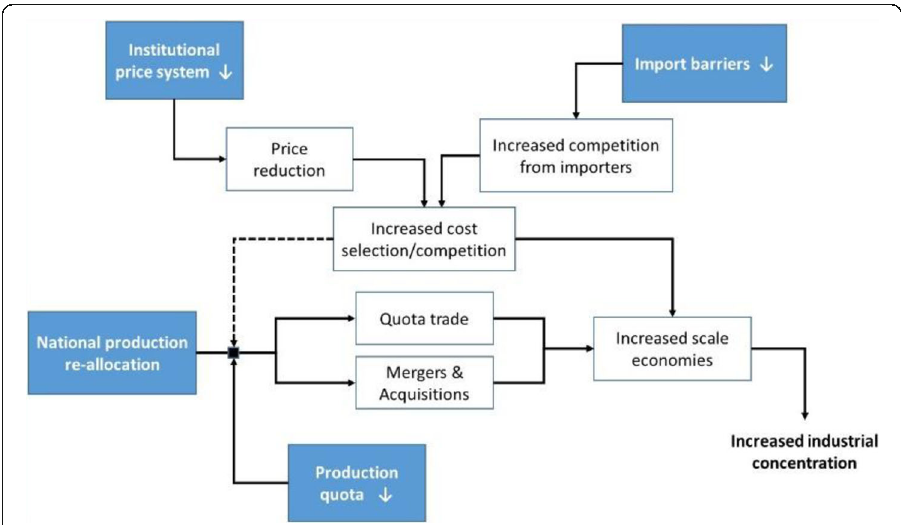
Fig. 1 Potential effect of sugar CMO Reform on concentration. Adapted from Areté srl Research and Consulting